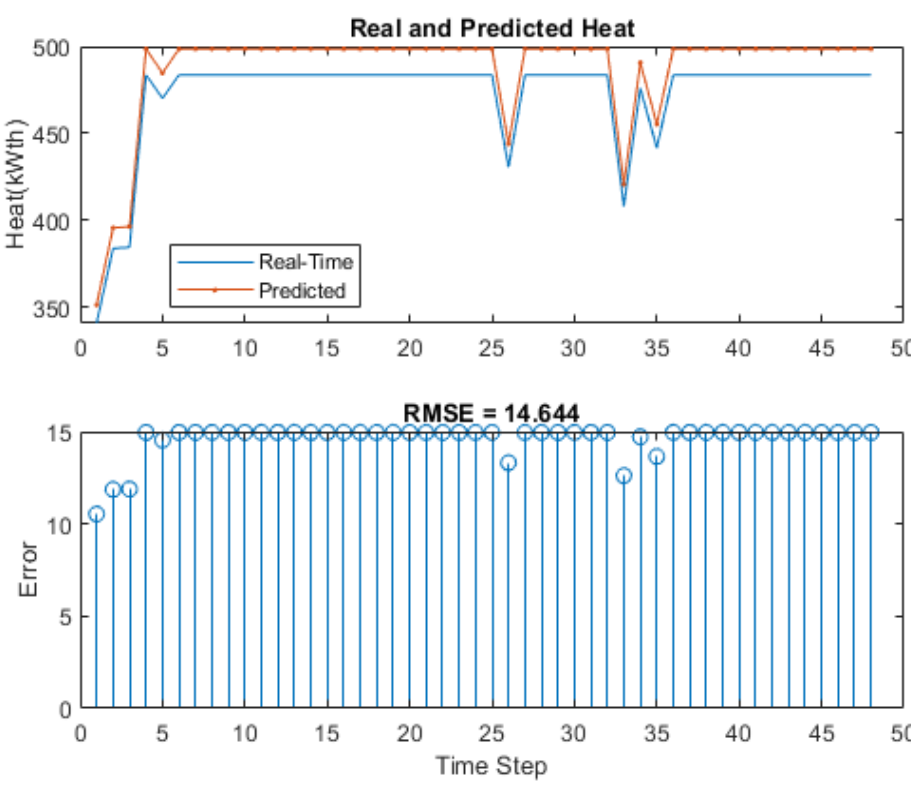
Figure 7. Real and Predicted Heat Demand with RMSE.